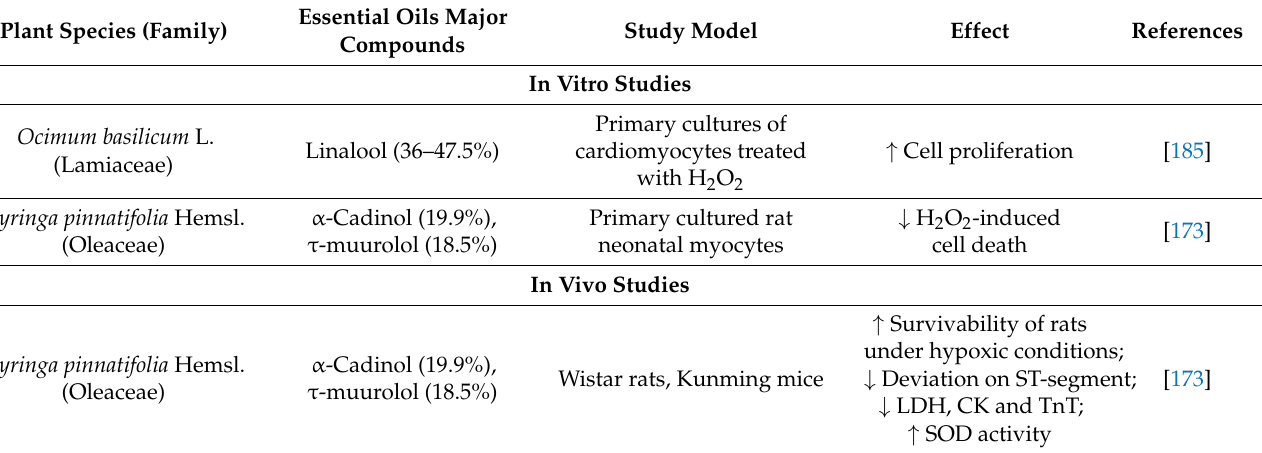
Table 5. Beneficial cardiovascular effects of essential